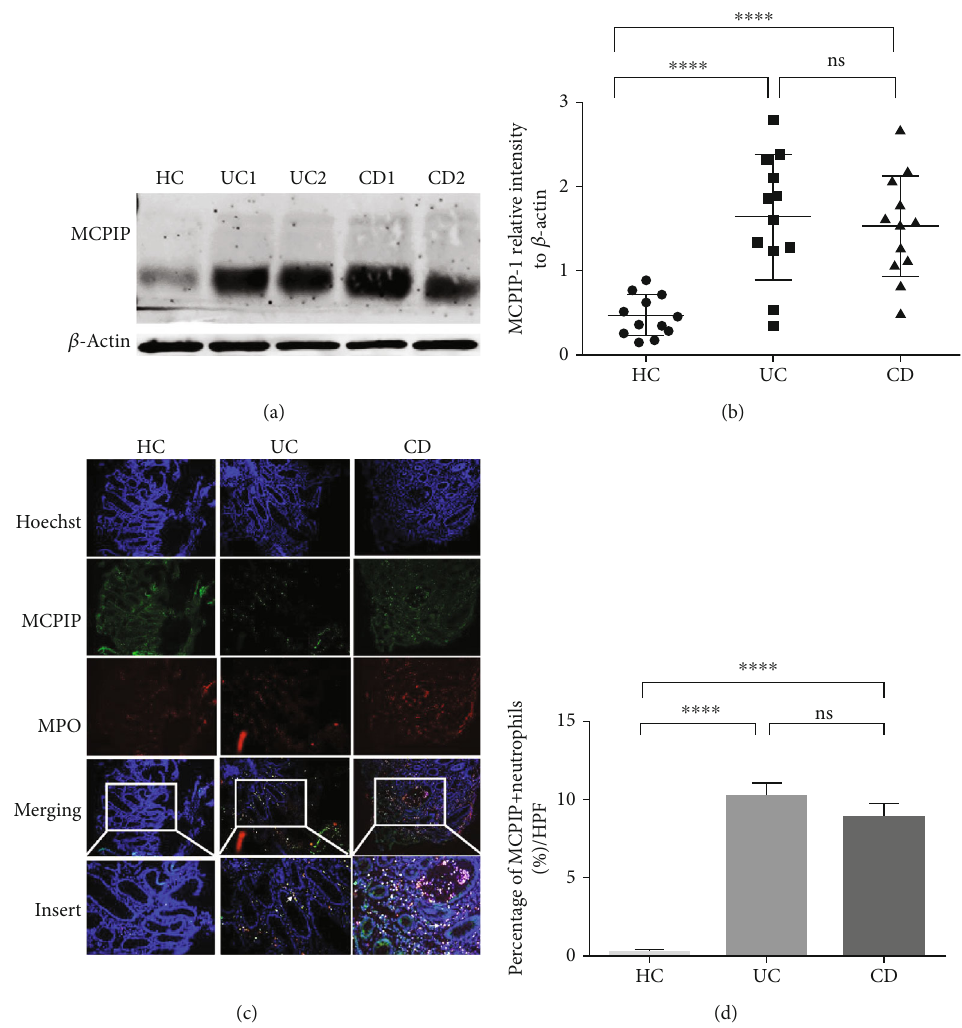
Figure 1: MCPIP-1 is highly increased in neutrophils of IBD patients. Peripheral neutrophils were isolated from patients with active CD ( n = 12 ) or active UC ( n = 12 ) and healthy donors (HC, n = 12 ). The protein levels of MCPIP were determined by Western blotting (a) and quanti fi ed in gray value (b). ∗∗∗∗ P < 0 : 0001 . Abbreviation: ns, not signi fi cant. (c) Representative images of double immuno fl uorescence staining for MCPIP-1 (green) and myeloperoxidase (MPO, red) expression in in fl amed colon from an active CD and an active UC patient, and normal colon mucosa of a HC. The arrows indicate double-positive cells after merging (original magni fi cation × 100 and insert × 200). (d) The histogram represents the percentage of double-positive cells in lamina propria of intestinal mucosa from HC ( n = 10 ), UC ( n = 10 ), and CD ( n = 10 ) patients per high-power fi eld (HPF). ∗∗∗∗ P < 0 : 0001 . Abbreviation: ns, not signi fi